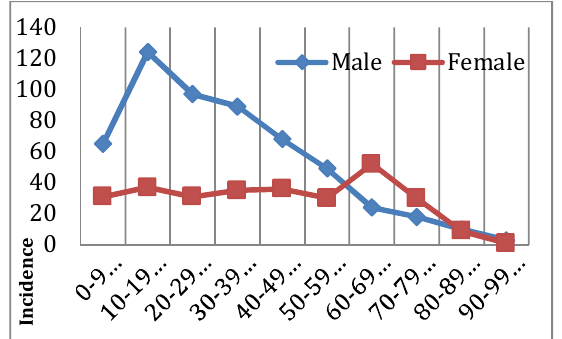
Figure 8. Age & Gender specific incidence in Trauma admissions